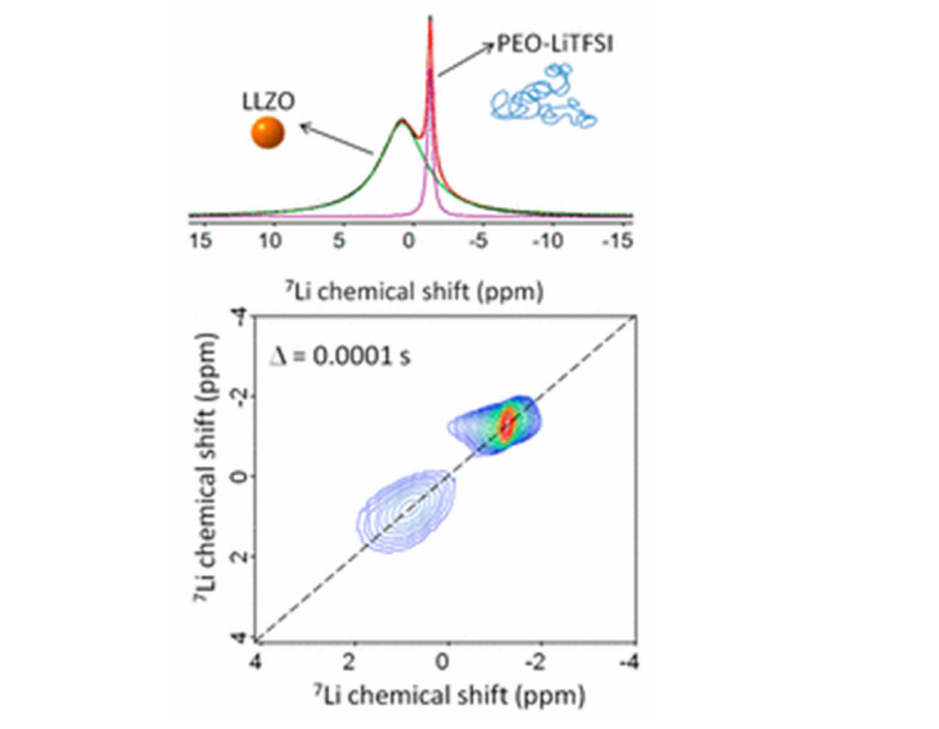
Figure 17. 7 Li one dimensional and EXSY spectra (14 MHz, 20 kHz MAS) of PEO-LiTFSI con- taining LLZO (Li 7 La 3 Zr 2 O 12 ). Reprinted with permission from [114]. Copyright 2019 American Chemical